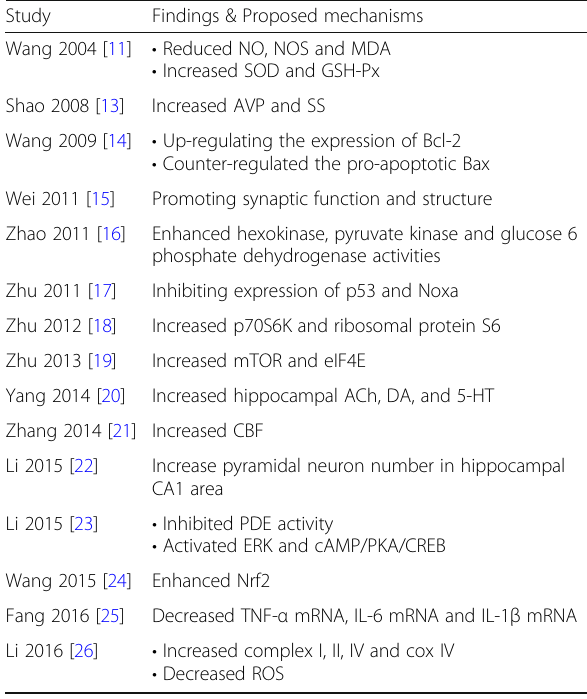
Table 4 Proposed mechanisms